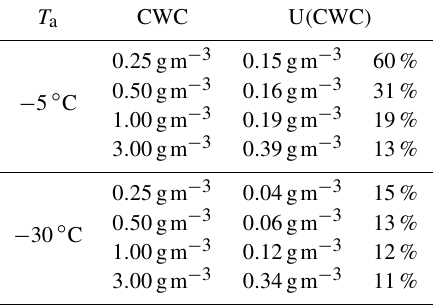
Table 1. Instrument absolute and relative CWC measurement un- certainties (95% coverage) at selected cloud CWC and at static air temperatures of − 5 and − 30 ◦ C. Wind tunnel airspeed and static air pressure for the calculations are 60ms − 1 and 1013 . 25hPa, respec- tively. T a